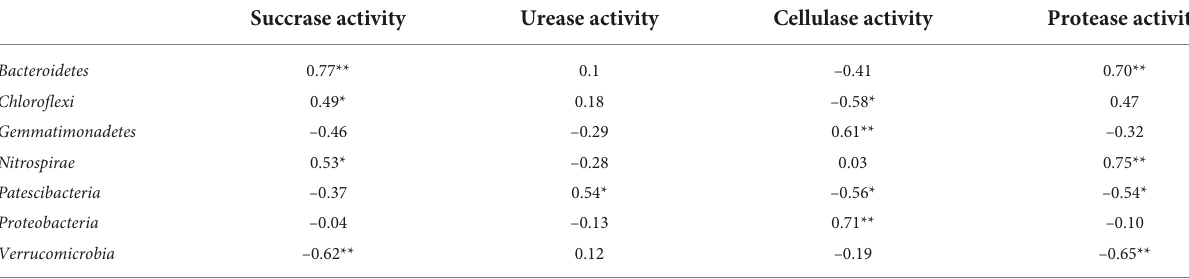
TABLE 4 Pearson’s correlation coefficients between abundant phyla, microbial biomass and enzyme activities.